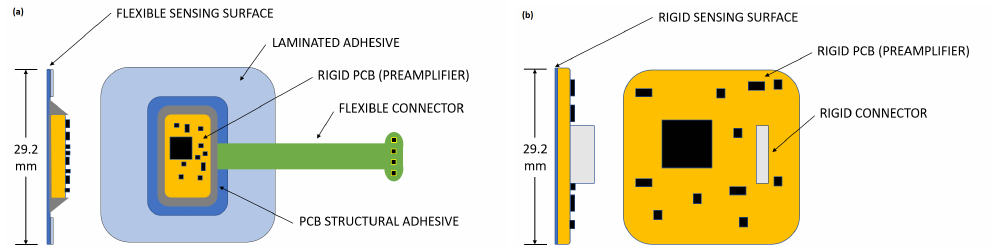
Figure 4. Component description of electrodes: ( a ) Flexible hybrid electrode proposed. ( b ) Reference rigid